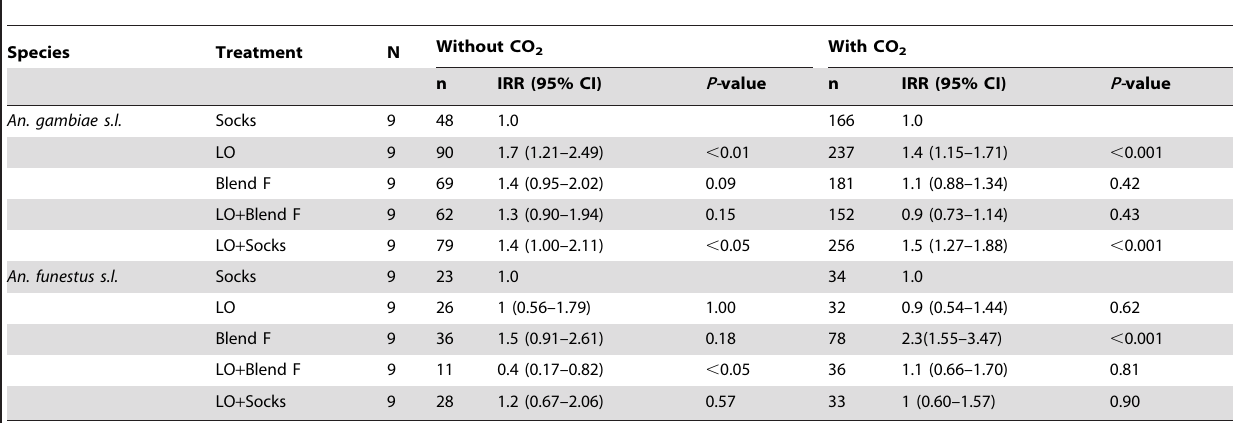
Table 4. Interactive effect of plant and animal/human lures on anopheline trap captures using MM-X traps.